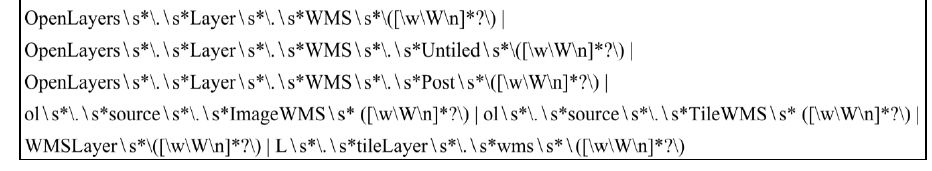
Figure 2. A regular expression representing the first rule. Table 2. Invocation functions and the formalization of the first